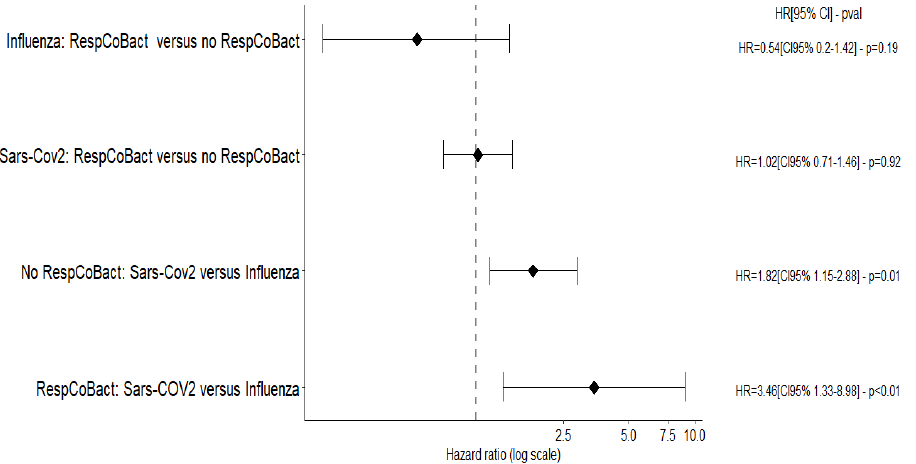
Figure 2. Association between SARS-CoV-2 or influenza and presence or absence of respiratory bacterial co-infection on admission and mortality at D60 (Cox multivariate survival model.) HR: hazard ratio at D60; RespCoBact: respiratory bacterial co-infection on admission in the Cox multivariate survival model adjusted for age, chronic cardiovascular diseases, immunodepression, PaO 2 /FiO 2 < 150, vasopressors, extrarenal purification, and beta-lactamase inhibitors.